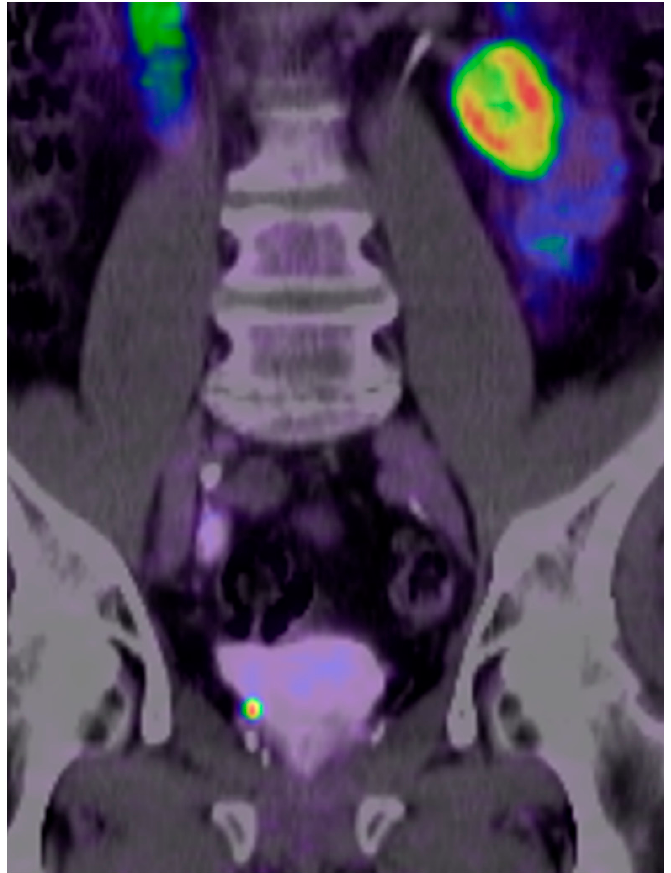
Figure 1. Case study of a prostate cancer (PC) patient who was pretreated with a radical prostatec- tomy, seminal vesicle removal, and lymphadenectomy (pT3a, pN0 [0/14], cM0, G3) in October 2020 with an initial prostate-specific antigen (PSA) of 6.77 ng/mL. Postoperatively incomplete PSA drop to 0.08 ng/mL. In April 2021 (time of PSMA imaging), the PSA level rose again to 0.197 ng/mL. [ 18 F]PSMA-1007 positron-emission tomography/computed tomography (PET/CT) shows a local re- current PC-lesion near the base on the right in the former seminal vesicle with high prostate-specific membrane antigen (PSMA)-avidity (maximum standardized uptake value/SUV max of 24.3 in the rou- tine images and of 32.4 in the late-stage images) as a correlate of the biochemical recurrence (BCR). (The imaging and data were collected from a Practice of Radiology and Nuclear Medicine in Co- logne/Germany, named “Praxis im KölnTriangle”).